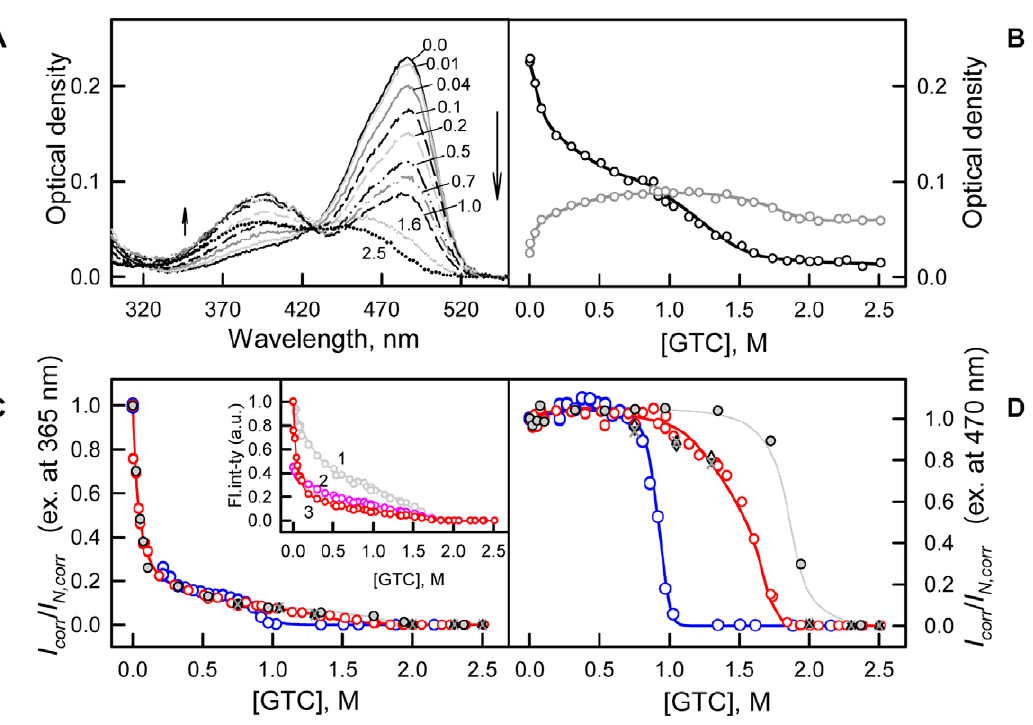
Figure 5. Conformational changes of sfGFP induced by GTC. ( A ) Changes of visible absorption spectra at increasing of GTC concentration as shown by arrows. Numbers at the curves indicate the denaturant concentration. ( B ) Changes of absorbance at 390 nm (gray circles and line) and 490 nm (black circles and line). ( C and D ) Changes of corrected fluorescence intensity of green chromophore at two wavelengths of excitation of 365 nm and 470 nm corrected to the change of chromophore absorption spectra. Red circles and line indicate unfolding, whereas blue circles and line represent refolding. Measurements were performed after 24 h incubation of native or denatured protein in the GTC presence. The values of chromophore intensity of sfGFP measured after incubation of native protein in the GTC presence during 1 h (gray circles and line), 45 h (black triangles), 69 h (reversed gray triangles) and 94 h (gray crosses) are also indicated. Inset to panel C : experimentally recorded (curve 1, gray), corrected to total density of solution as I/W, where W ~ (1 { 10 { D S ) = D S (curve 2, pink), and corrected to the change of chromophore absorption spectra (see, panel C ) on GTC concentration (curve 3, red) [47,48,49].